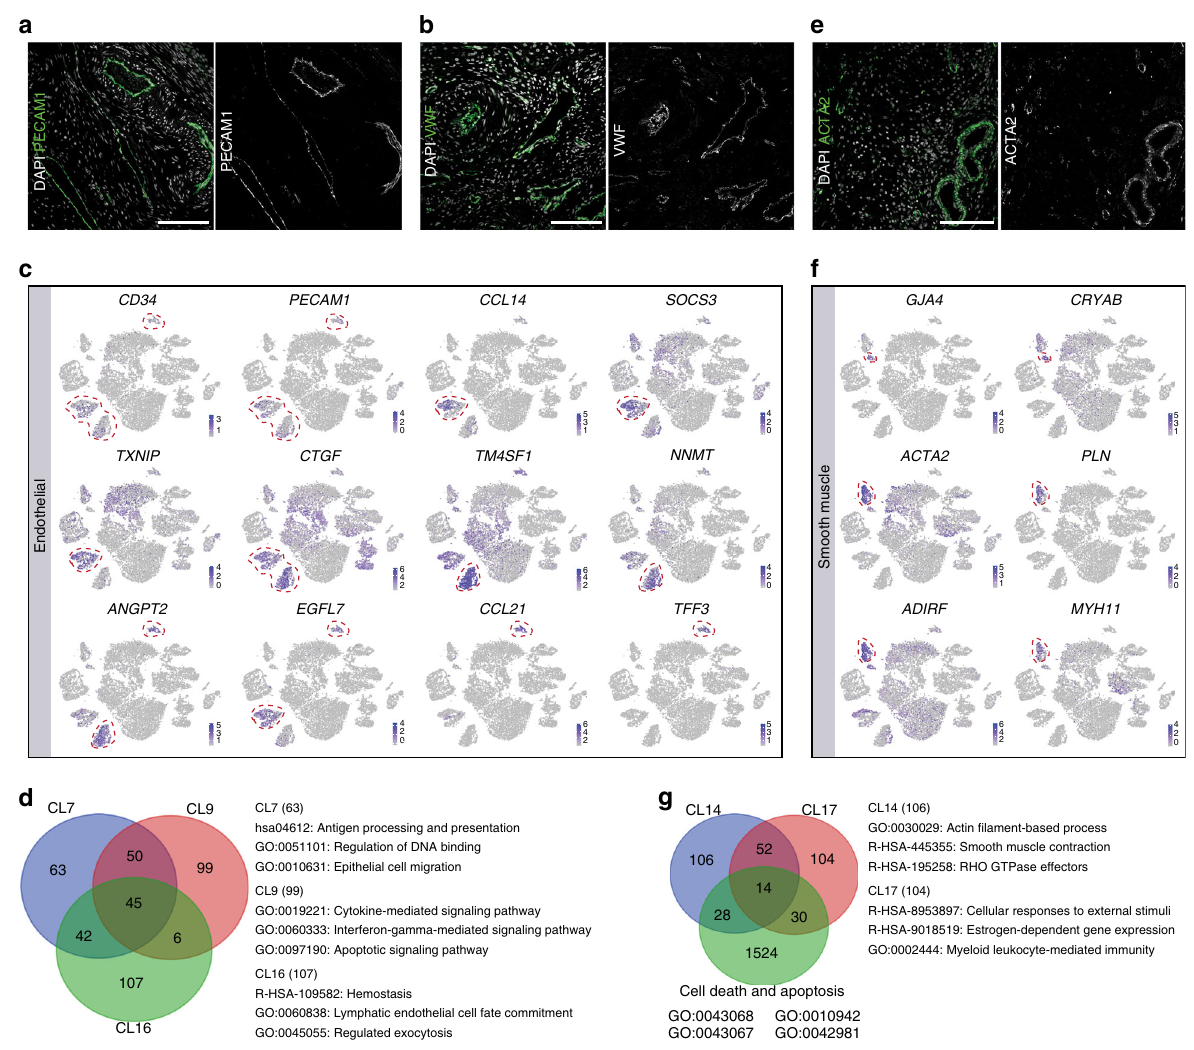
Fig. 3 Vascular remodeling in the ovaries analyzed. a , b Immuno fl uorescence of ovarian stroma for PECAM1 a , VWF b , and the respective single channel images. Slides were counterstained with DAPI. Scale bars are 100 μ m. c tSNE cluster maps showing expression of selected endothelial marker genes. Red dashed lines give the boundaries of the endothelial-clusters of interest. d Venn diagram showing the intersection of 200 differential expressed genes (DEGs) of the three endothelial cell clusters (CL7, CL9, and CL16); and three selected enriched terms obtained for the unique DEGs. e Immuno fl uorescence of ovarian stroma for ACTA2, and the respective single channel image. Slides were counterstained with DAPI. Scale bars are 100 μ m. f tSNE cluster map showing expression of selected smooth muscle marker genes. Red dashed lines give the boundaries of the smooth muscle-clusters. g Venn diagram showing the intersection of 200 differential expressed genes (DEGs) of the two smooth muscle cell clusters (CL14 and CL17) and genes from four-cell death and apoptosis-related GO terms (GO:0043068 positive regulation of programmed cell death, GO:0010942 positive regulation of cell